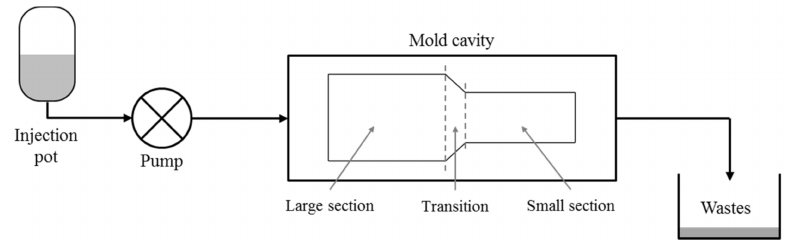
Figure 10. Schematics of the experimental RTM manufacturing